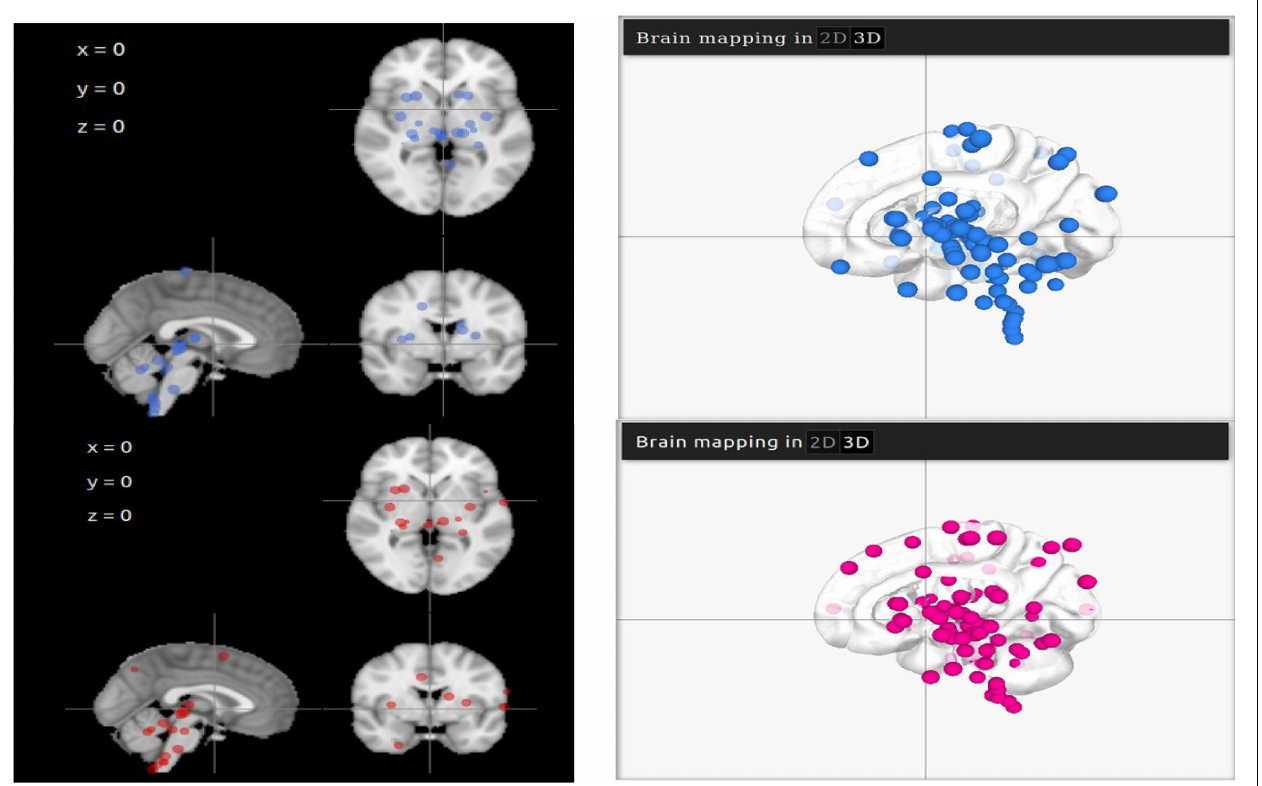
FIGURE 1 | 2D and 3D visualisations of ACE2 (in blue) and TMPRSS2 (in magenta) mRNA overexpressions in the brain. The differences in 3D visualisation color intensity result from the transparency of the brain and the juxtaposition of several